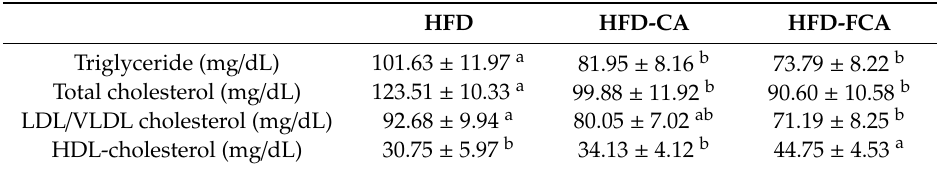
Table 4. Serum lipid profiles in rats fed experimental